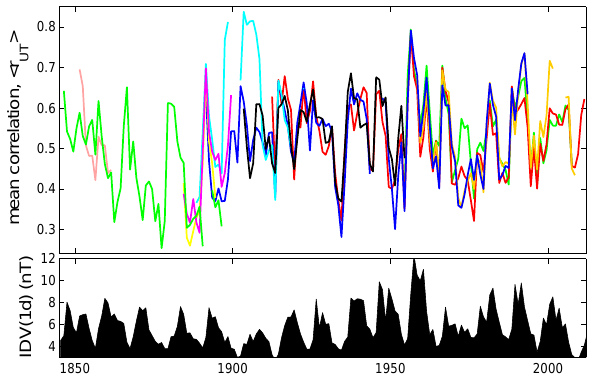
Fig. 2. (Top) The mean < r UT > of the 276 correlations obtained by correlating each monthly IDV(UT) time series with that for each of the other 23UTs. The correlations are carried out over 3yr windows (i.e. using 36 monthly means) that are incremented by 1yr. The sta- tions are colour-coded using the same coding as used in Fig. 1. The additional black line is for the Cheltenham magnetometer. (Bottom) Annual means of the composite IDV(1d) variation derived later in this